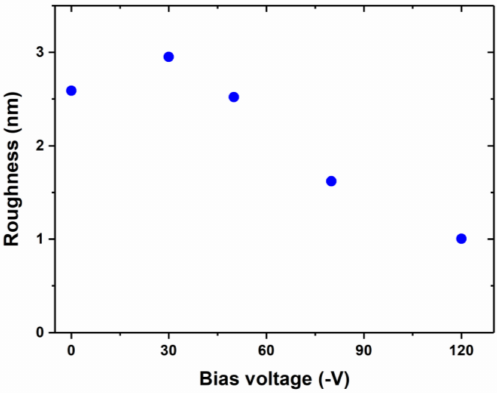
Figure 6. Surface roughness of the Ta coatings deposited by DOMS with di ff erent bias voltage.